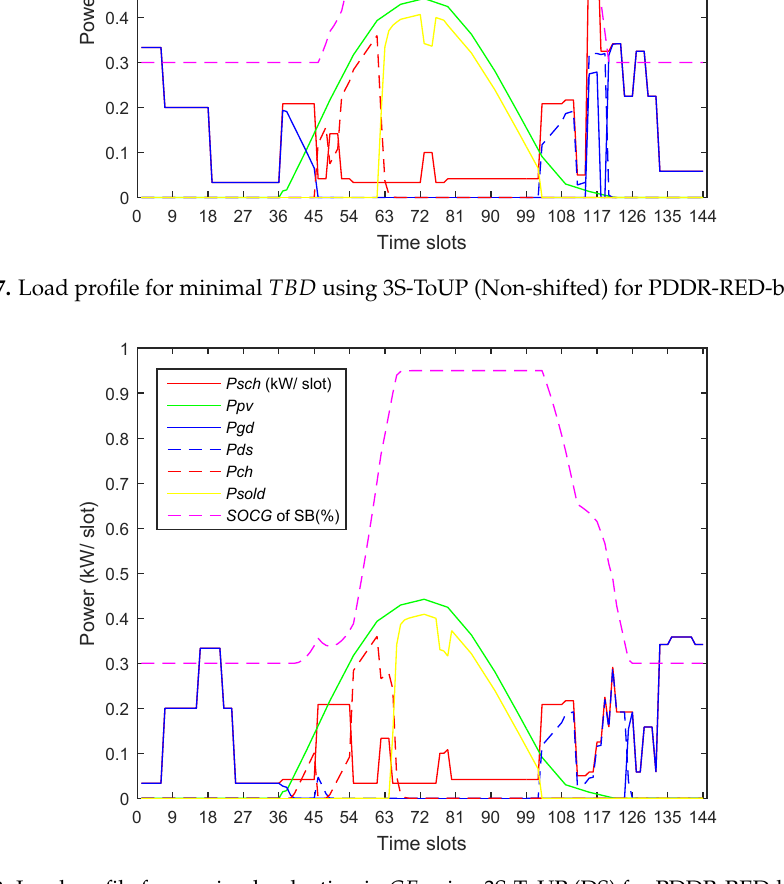
Figure 28. Load profile for maximal reduction in CE using 3S-ToUP (DS) for PDDR-RED-based